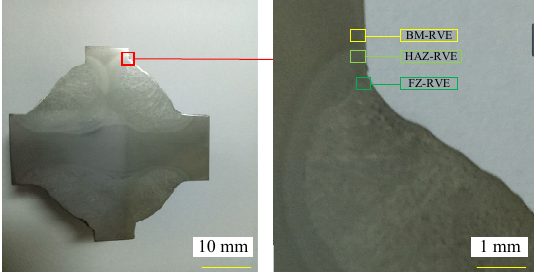
Figure 2. Weld toe three-zone two-dimensional representative volume element.